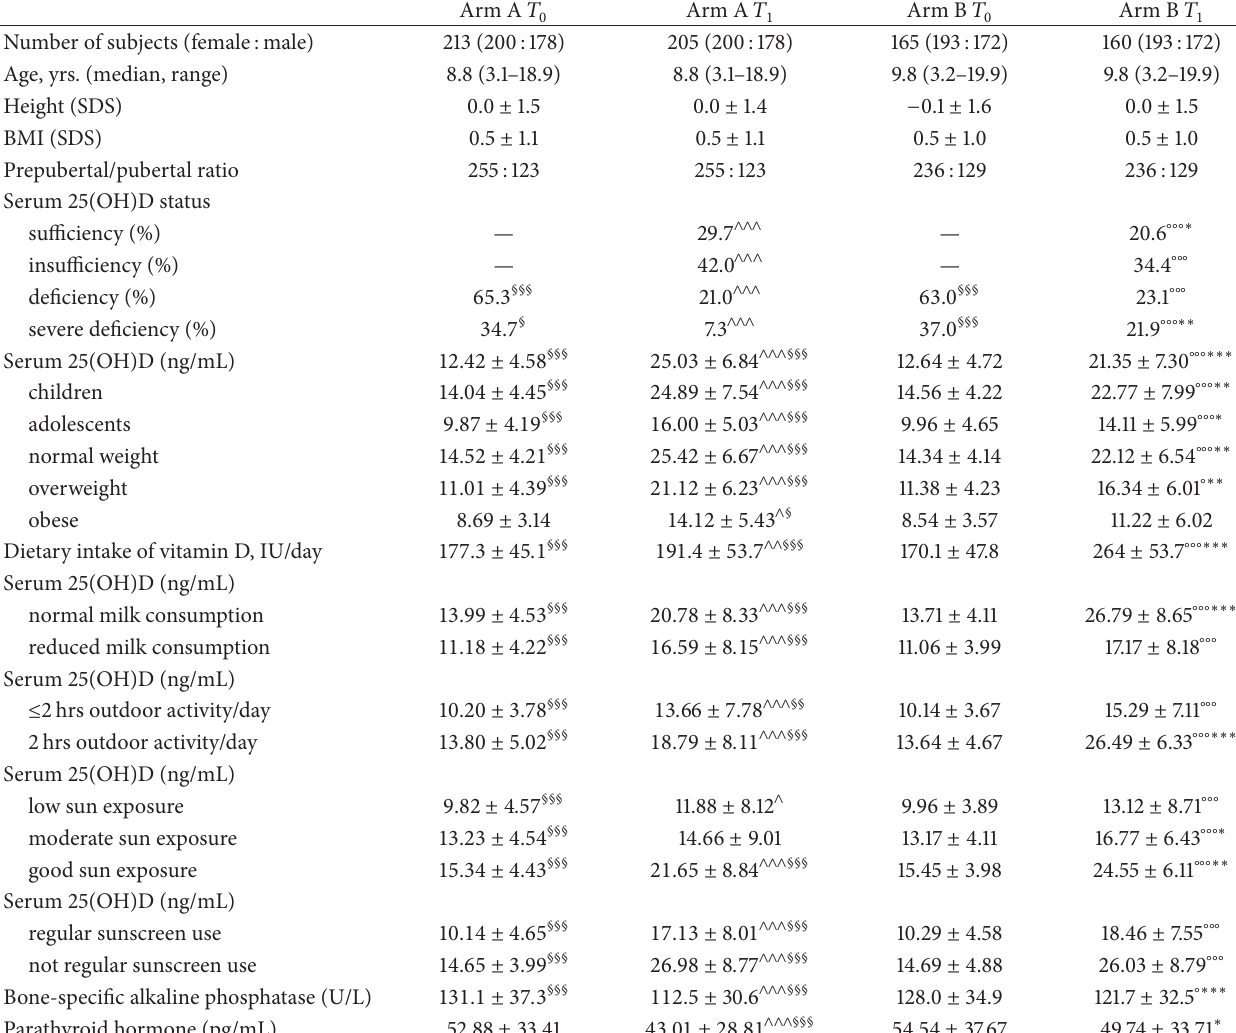
Table 2: Comparison of 25(OH)D determinants in Arms A and B of the interventional